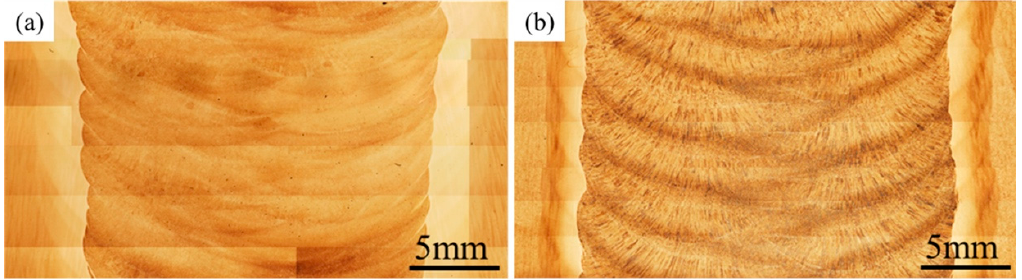
Figure 2. Macrographs of weld metal: ( a ) TIG, ( b ) SAW.